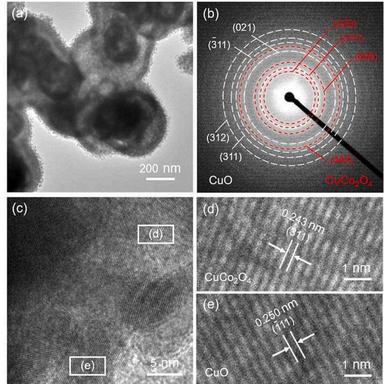
(a) TEM image of several CuCo2O4/CuO microspheres aggregated together, (b) SAED pattern, and (c–e) HRTEM images of CuCo2O4/CuO microspheres.